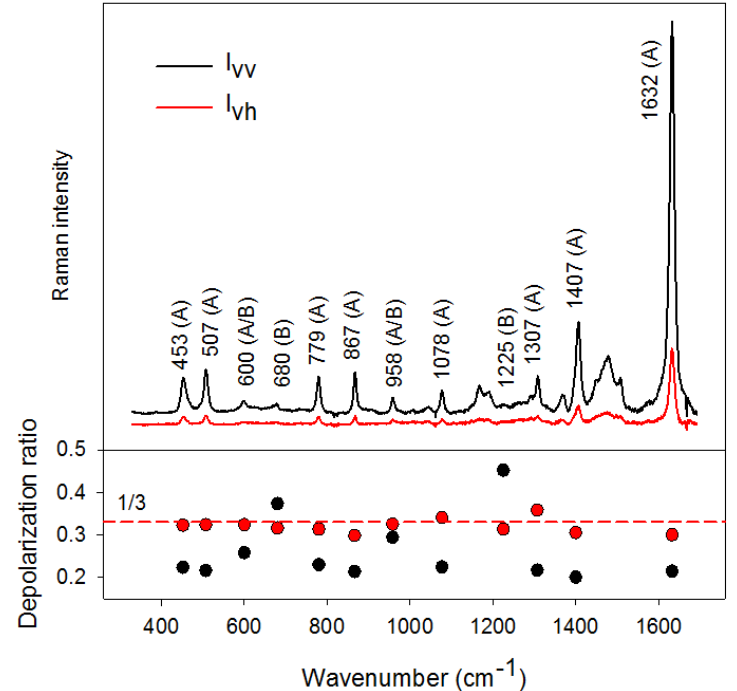
Figure 10. Polarized (preresonance) Raman spectra of methylene blue (MB) in a water solution (excitation wavelength 532 nm; after fluorescence baseline subtraction) and corresponding depolarization ratios (black dots). Symmetry species of respective vibrational modes are indicated in the upper part. Comparison with the depolarization ratios obtained from hydroxylamine-reduced Ag NPs is indicated by red dots (SERS spectra are not shown for better clarity). MB concentration was 10 − 4 M, laser power 100 mW, accumulation time 5 min.